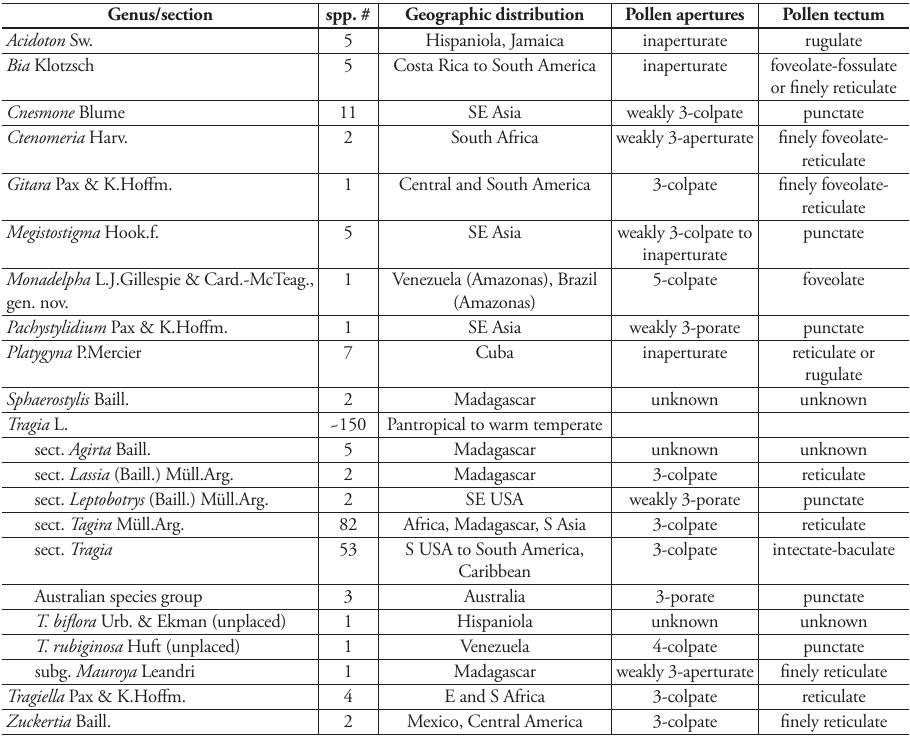
Table 1. Tragiinae genera and infrageneric taxa of Tragia : species number, geographic distribution, and pollen morphology. Adapted from Cardinal-McTeague and Gillespie (2016) with pollen characters from Gillespie (1994a, 1994b) and taxonomic updates from this paper. Genus/section spp. # Geographic distribution Pollen apertures Pollen tectum Acidoton